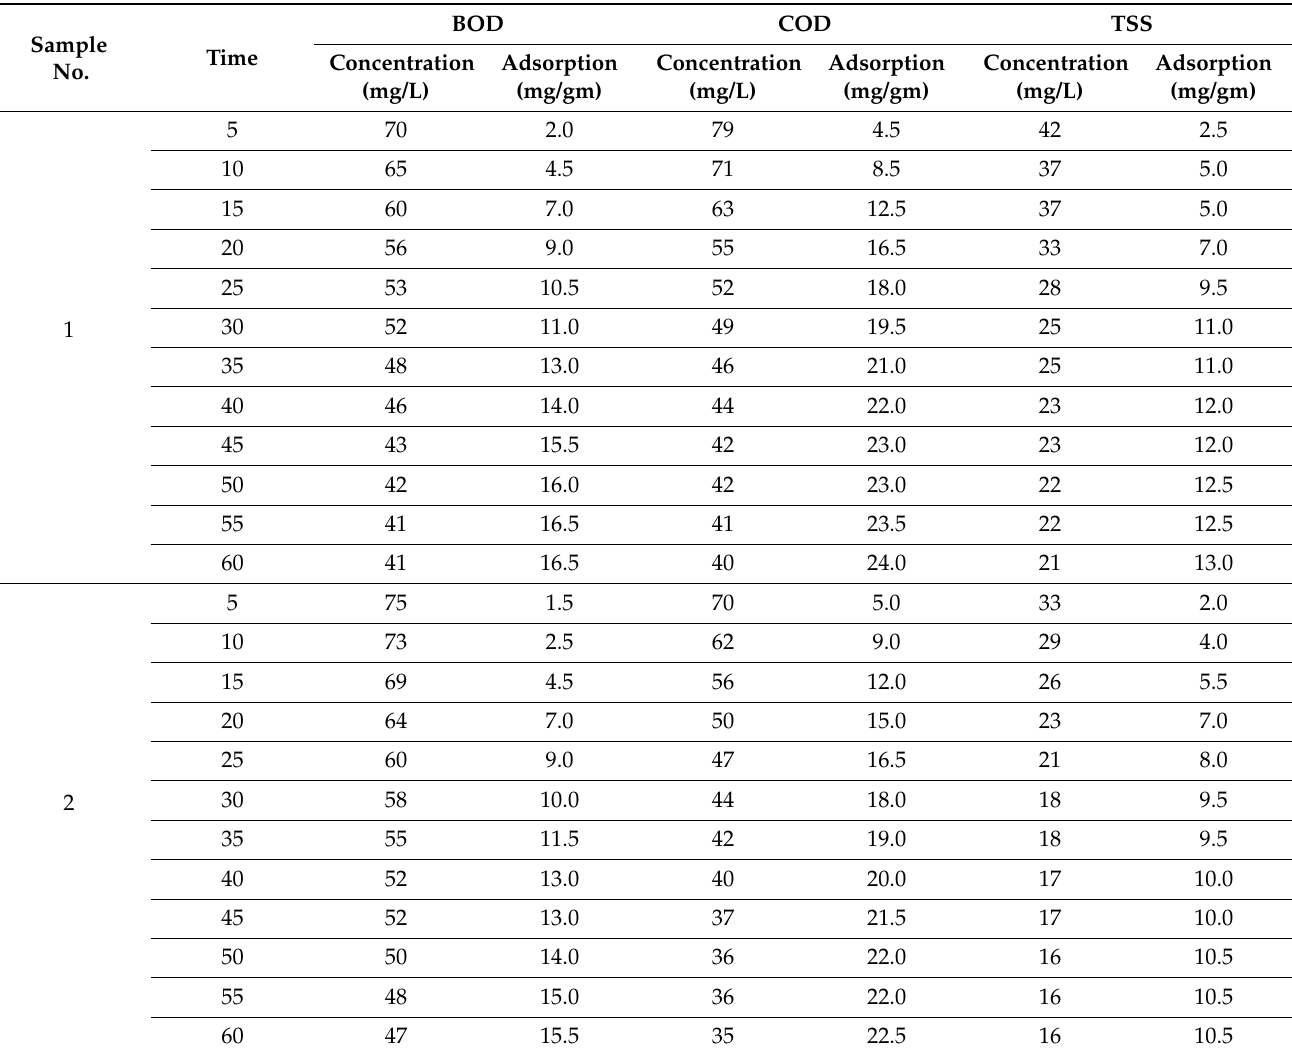
Table 6. Adsorption concentrations (mg/gm) of BOD, COD and TSS from industrial wastewater at different time